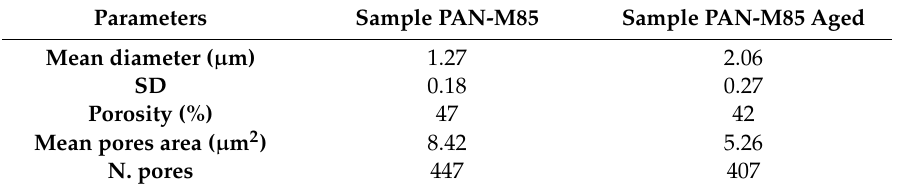
Table 2. Main morphological characteristics of the aging test for PAN-M85. All reported parameters are mean values of three measurements by digital image analysis of di ff erent samples.